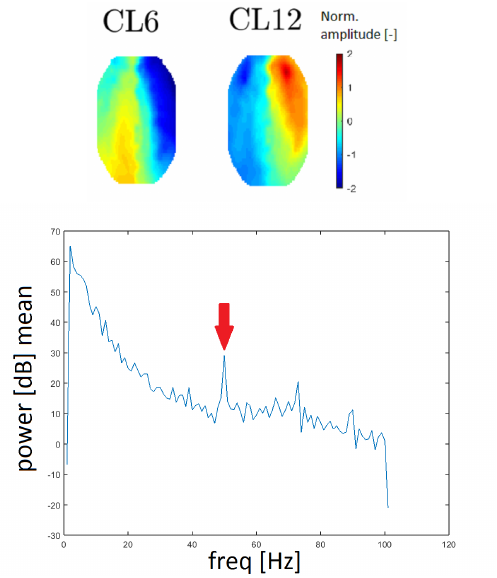
Figure 13. Topomaps of clusters CL6 and CL12, which have a distinctive peak at a frequency of 50 Hz, as line noise artifacts ( top ). The mean power spectrum of cluster CL6 with a distinctive peak at a frequency of 50 Hz